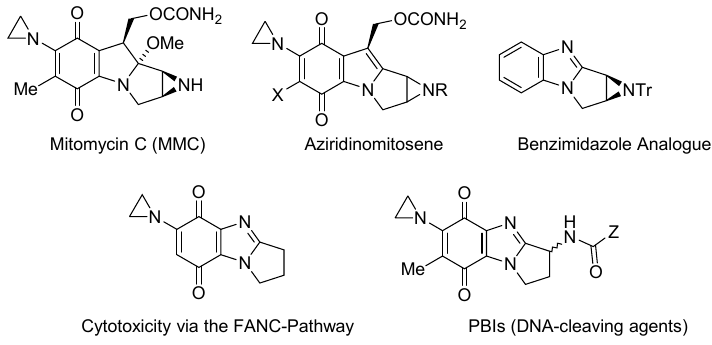
Figure 3. Aziridinyl-functionalized antitumor agents [11–18]. One or two-electron reductases are responsible for bioreductive activation. NADPH- cytochrome c (P450) reductase is predominant under hypoxic conditions with the one- electron reduction reversed by oxygen [19]. Many solid tumors also over-express the ob- ligatory two-electron reductase NAD(P)H:quinone oxidoreductase 1 (NQO1, also known as DT-diaphorase), which is a popular target for anti-cancer studies [20]. Many anti-cancer agents do not contain conventional DNA damaging functionality, and cytotoxicity may